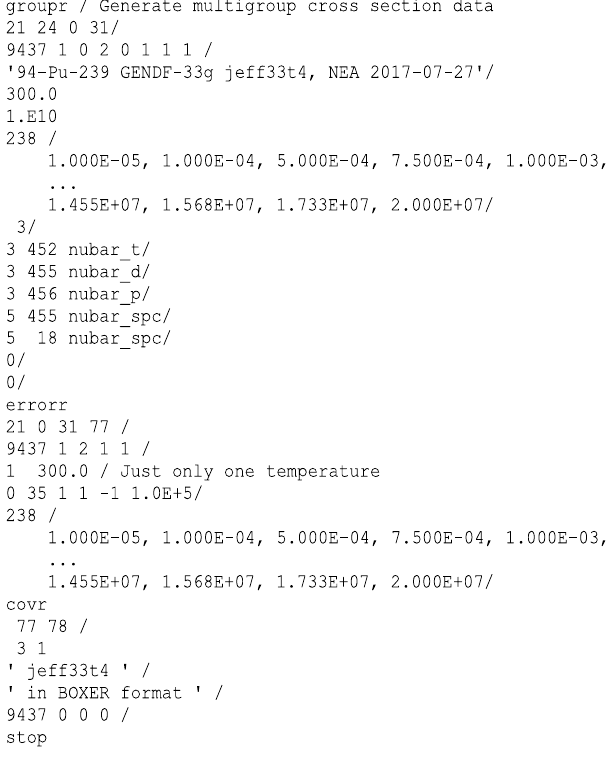
Fig. 4. An example of NJOY input to process MF35/PFNS covariance.